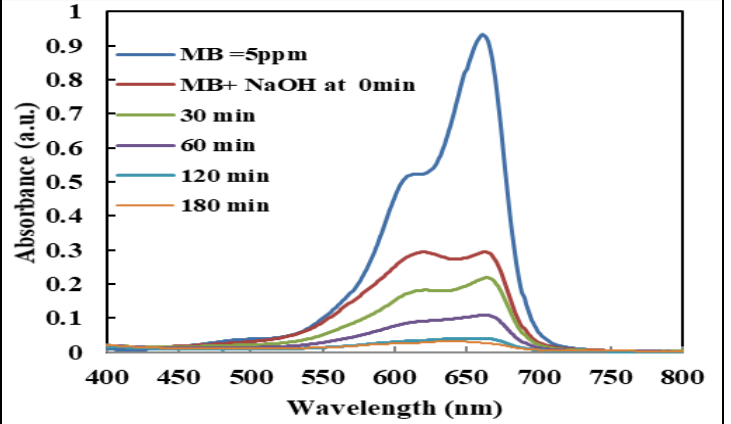
Figure 3: UV-Vis. absorption spectra of MB (5ppm) with pH =8 catalysis by ZnO/epoxy nanocomposite (2 wt.